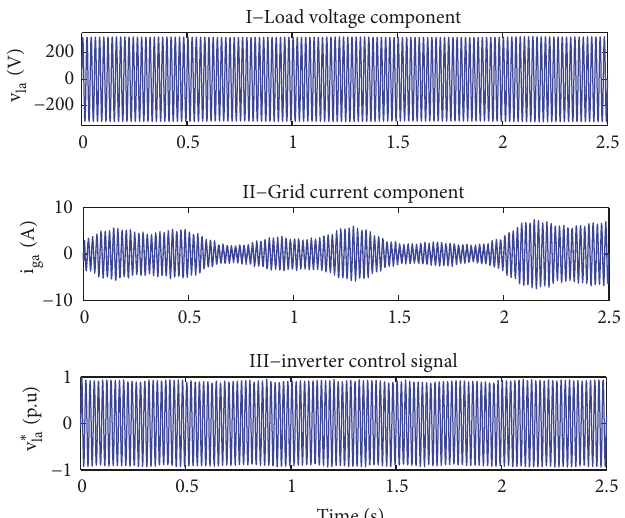
Figure 10: Performances of the grid side PI controllers in grid connected mode. Load phase voltage component (i), grid phase current component (ii), and inverter control signal